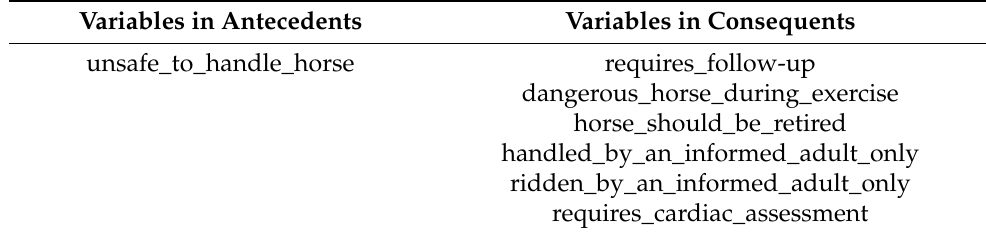
Table 6. Subsystem IV (management). Conclusions about horse